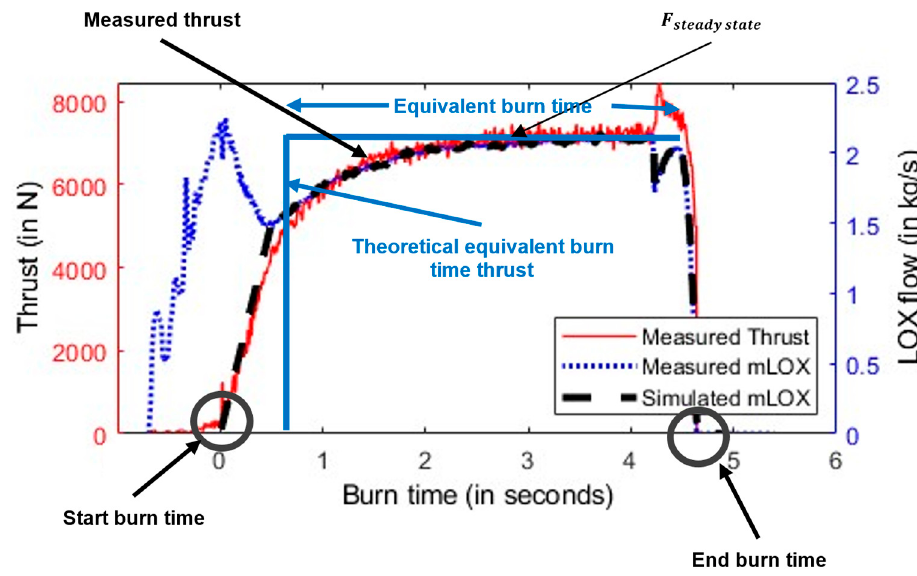
Figure 5. Burn time equivalent principle